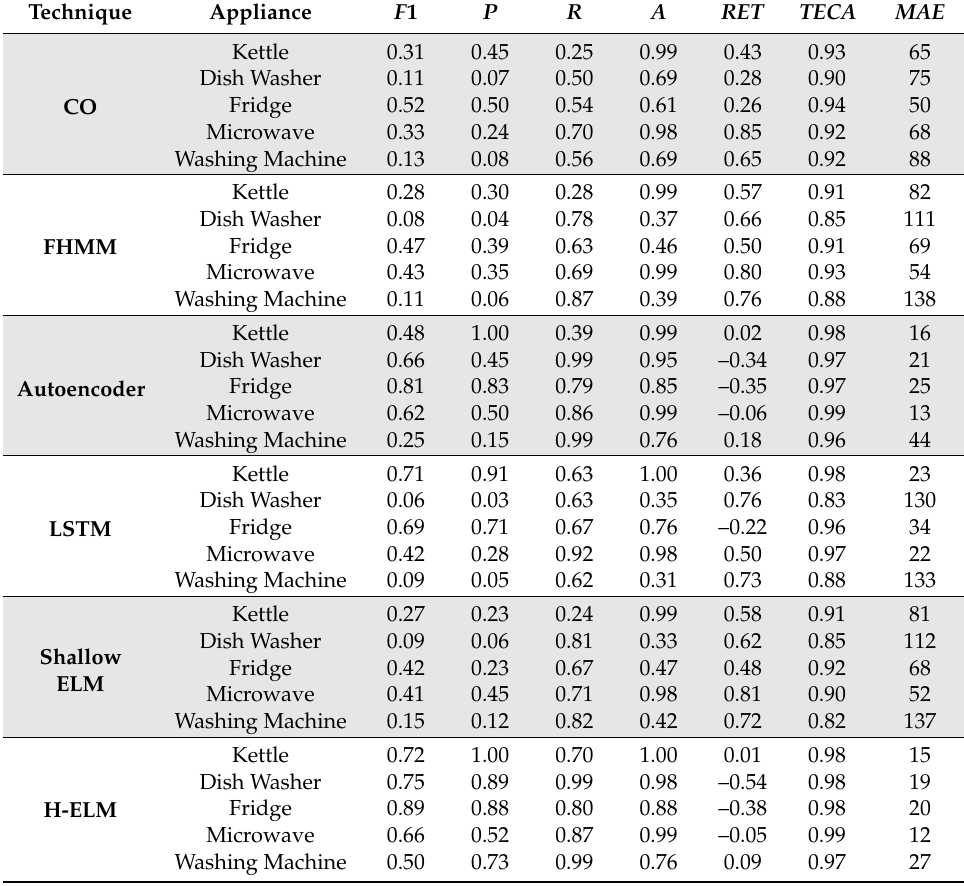
Table 3. Disaggregation performance for seen houses during